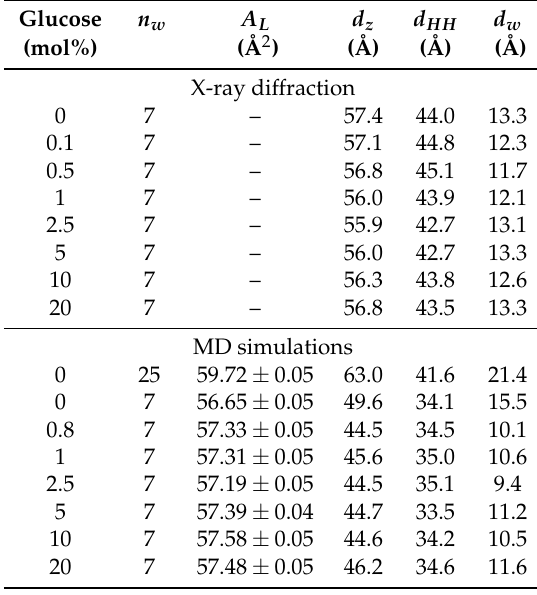
Table 2. Summary of the experimental and simulated structural parameters. Given are the number of water molecules, n w , the area per lipid molecule, A L , lamellar spacing, d z , membrane width, d HH , and hydration water layer thickness, d w . The area per lipid tail was determined from the experiments to be 20.25 Å 2